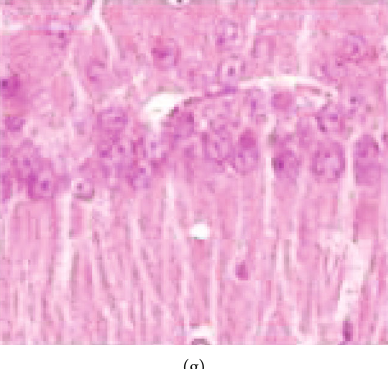
Figure 12: H&E staining images in experimental groups. The e ff ects of di ff erent doses of selegiline on neural cell death of hippocampus. Cell death was evaluated via hematoxylin-eosin (H&E) staining at 400x magni fi cation. (a):control group; (b) stroke or untreated transient global ischemia rats; (c) nonischemic rats received only noisome+NBP; (d) nonischemic rats received 1 mg/kg of selegiline in niosomal selegiline- NBP structure; (e) stroke rats received selegiline (0.25 mg/kg) in niosomal selegiline-NBP structure; (f) stroke rats received selegiline (0.5 mg/kg) in niosomal selegiline-NBP structure; (g) stroke rats received selegiline (1 mg/kg) in niosomal selegiline-NBP structure. Arrows indicate dead